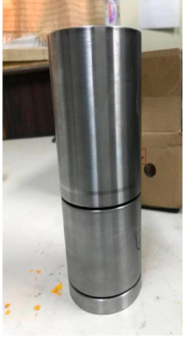
Figure 1. Eruption device.